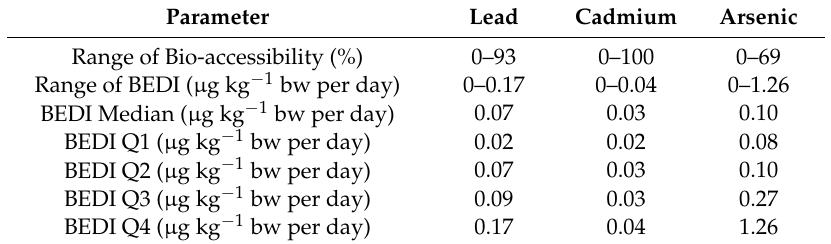
Table 3. Percentage range of bio-accessibility (minimum–maximum) for lead, cadmium, and arsenic in diet ( n = 10). Range of Children’s Bio-accessible Estimated Daily Intake (BEDI) per body weight